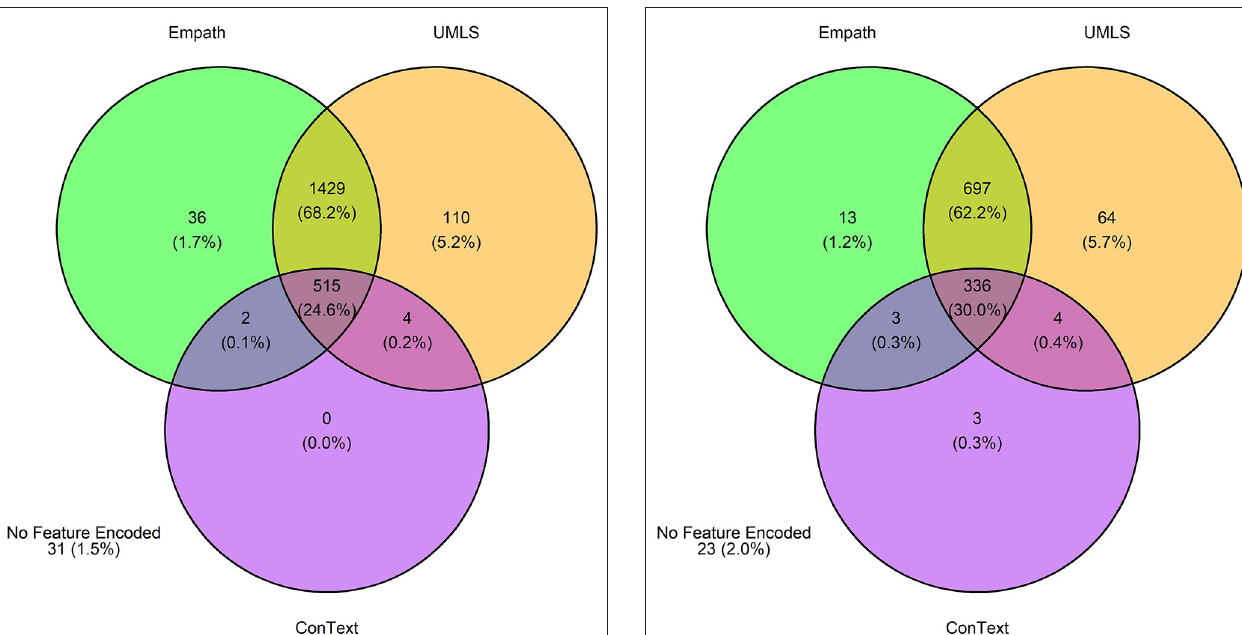
encoded incorrect semantics. For example, Empath incorrectly interpreted “change in mental status,” identifying “change” as money, and UMLS spuriously interpreted “pt expresses the